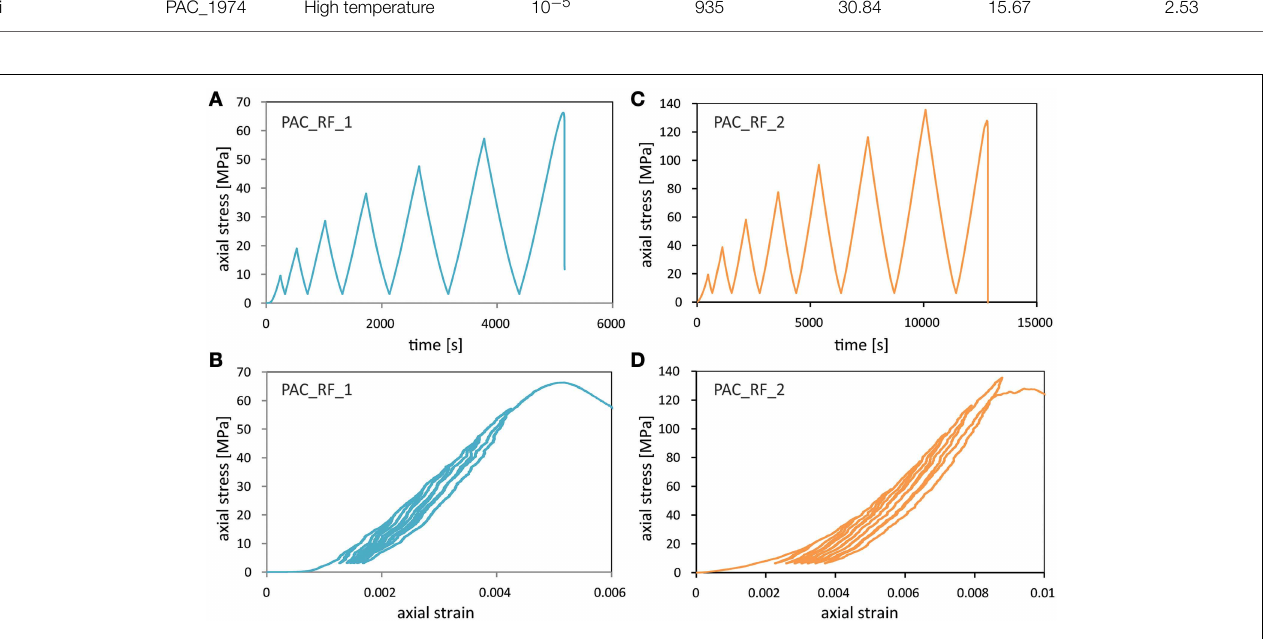
(B) Cyclic deformation and unloading shows hysteresis as strain is accumulated. (C) During cyclic loading of sample PAC_RF_2 deformed at 10 − 5 s − 1 failure is achieved at a stress lower than the peak stress reached in the penultimate cycle. (D) The sample is subjected to a stronger damage accumulation, and hysteresis, than sample PAC_RF_1, which may explain why this sample failed at a total stress lower than previously